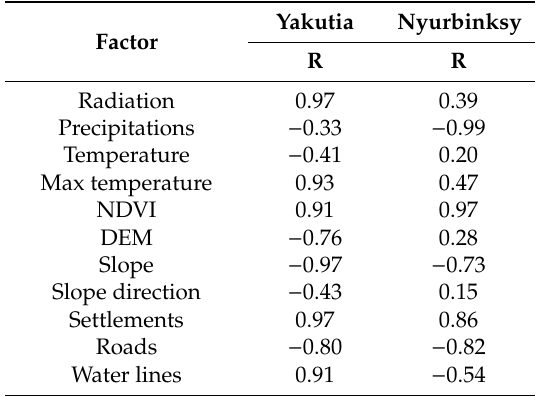
Table 2. Coe ffi cient of correlation for each variable in the Republic of Sakha (Yakutia) and the Nyurbinsky